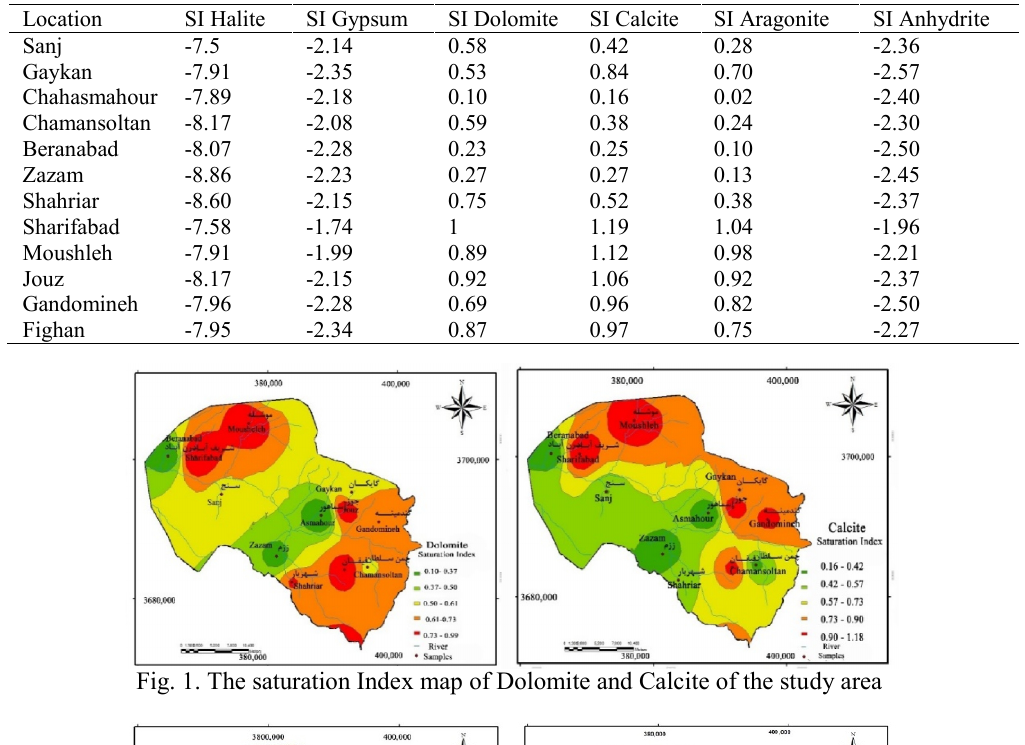
Table1. Saturated Index of minerals of groundwater in the study area Location SI Halite